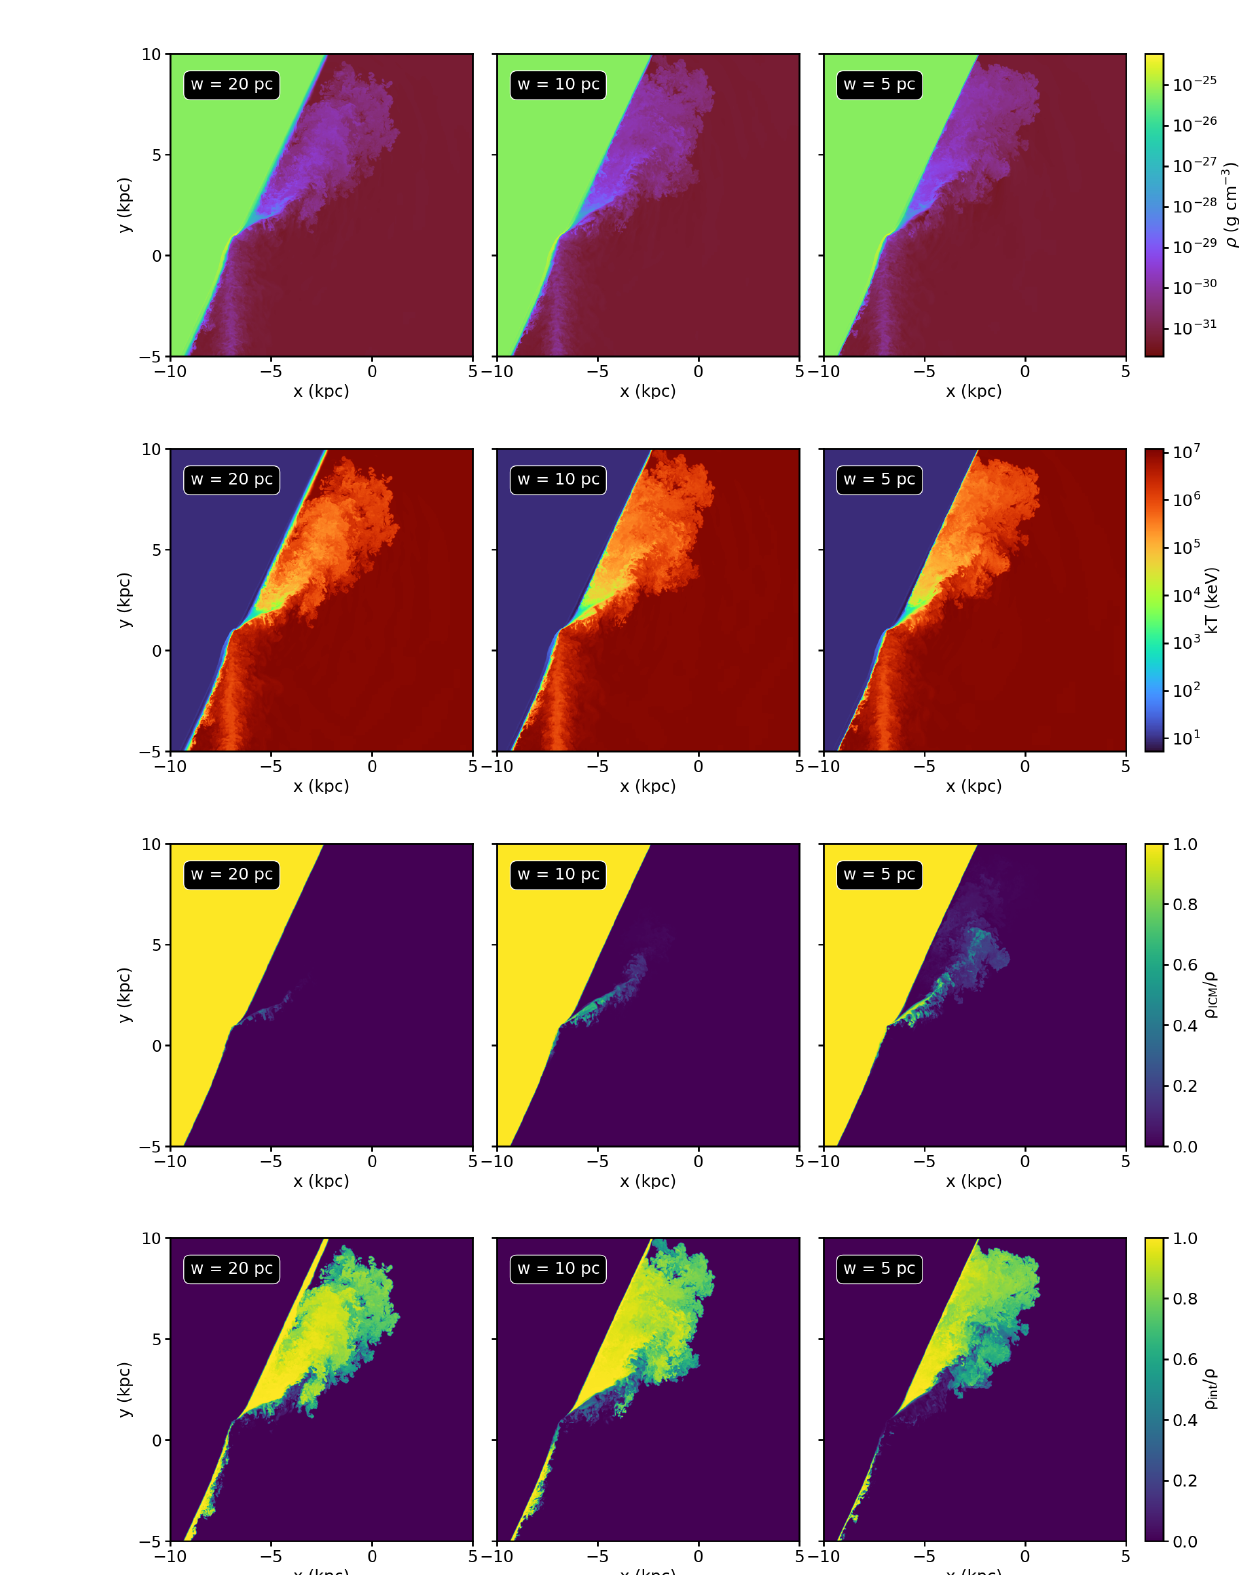
Figure 7. Slices at t = 125 kyr, showing the effect of varying the width of the interface. First row: density, second row: temperature, third row: “ICM” passive scalar, fourth row: “interface” passive scalar. Each panel is 15 kpc on a side, zoomed in slightly to focus on the parts of the simulation most affected by the